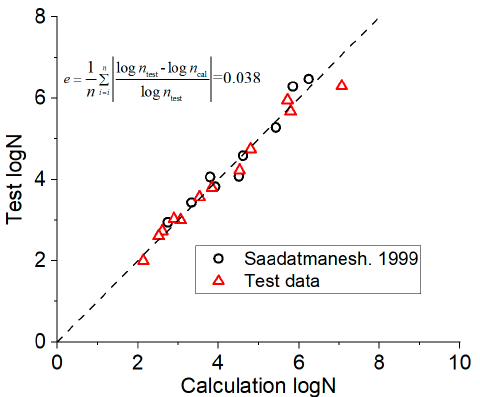
Figure 9. Between calculation results of prediction Equation (3) and test results.